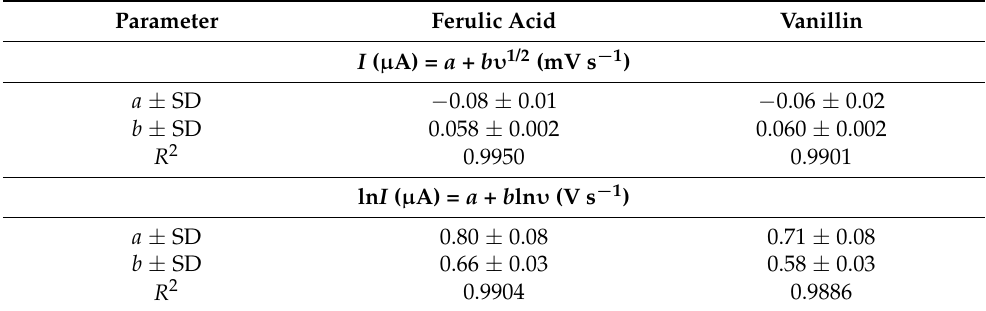
Figure 10. CVs of 10 µM ferulic acid ( a ) and vanillin ( b ) on polyBCP/f-SWCNTs/GCE in BRB, pH 2.0 (curve 1), at various potential scan rates (10 (curve 2), 25 (curve 3), 50 (curve 4), 75 (curve 5), 100 (curve 6), 125 (curve 7) and 150 (curve 8) mV s ‒ 1 ). Table 2. Effect of potential scan rate on the oxidation currents of ferulic acid and vanillin on polyBCP/f-SWCNTs/GCE in BRB, pH 2.0.